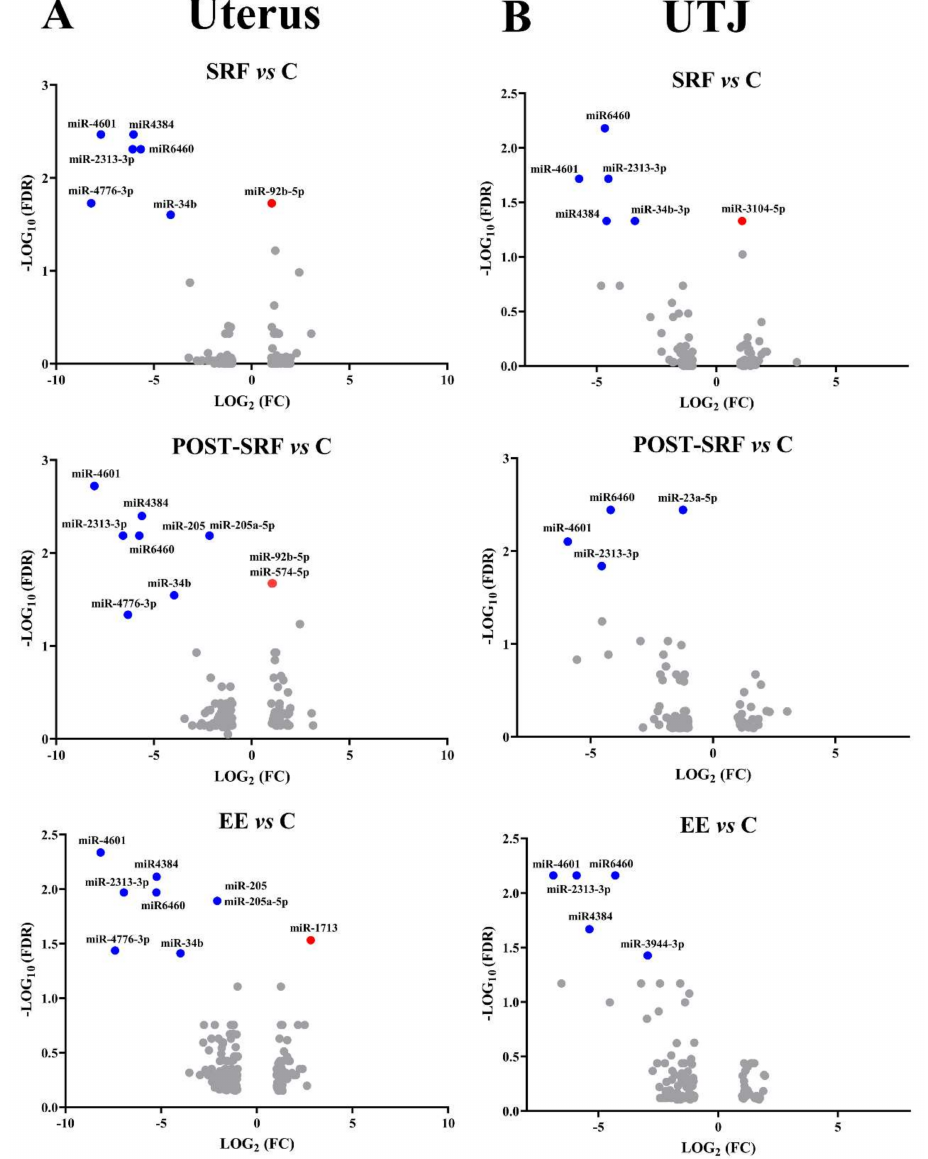
Figure 3. Volcano plots showing microRNAs (miRNAs) di ff erentially expressed ( p -value < 0.05 and ≥ 2.0-Fold Change (FC) or ≤− 2.0-FC) in the medium retrieved from ( A ) uterus and ( B ) utero-tubal junction (UTJ) mucosal explants exposed to di ff erent treatments: Medium 199 (M199) supplemented with seminal plasma from di ff erent ejaculate fractions (sperm-rich fraction (SRF) and post-SRF) and from the entire recomposed ejaculate (EE), compared with its control (C, M199 alone). Top left blue dots represent downregulated miRNAs with a False Discovery Rate (FDR) < 0.05 and FC > − 2 and top right red dots represent upregulated miRNAs with an FDR < 0.05 and FC >